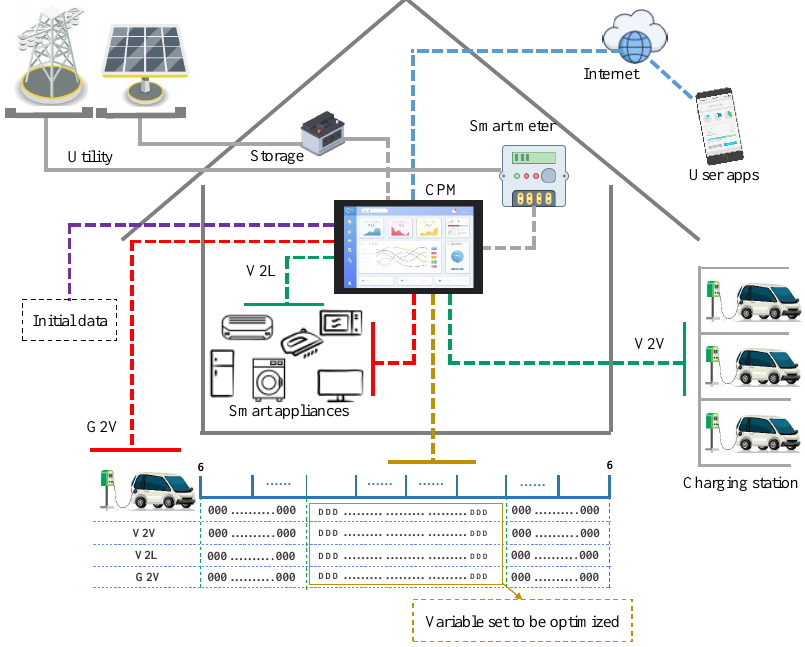
Figure 1. Overview of a single smart